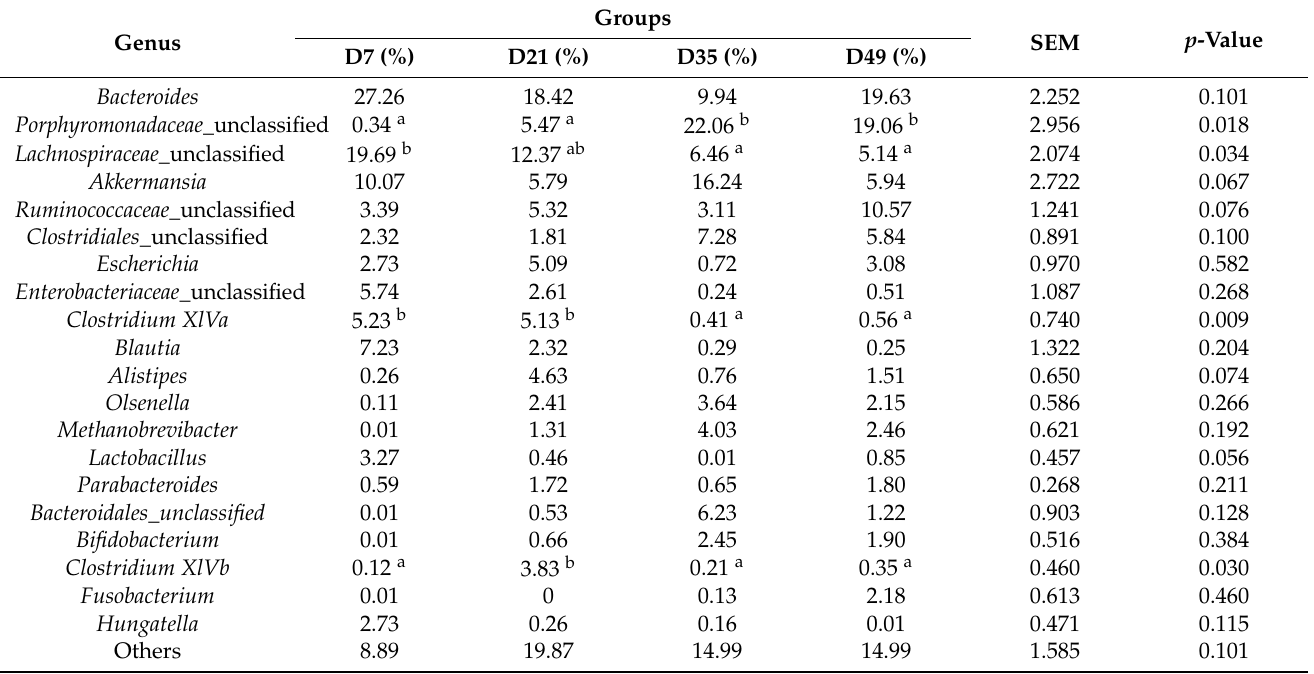
Figure 3. Relative abundance of the feal microbial compositions at the phylum level in early lambs. The mean value of relative abundance (given as a percentage) of the top 17 phyla at each timepoint are shown. Table 3. Top 20 taxonomic composition at the genus-level of the gut microbial